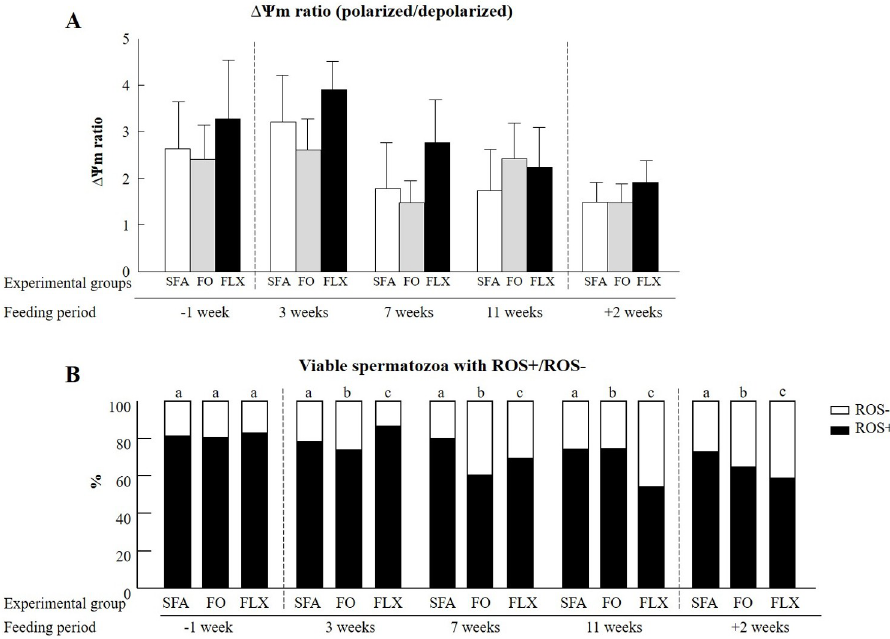
Fig 4. The effect of omega-3 sources flaxseed and fish oil on mitochondrial features. (A) The ratio of mitochondrial membrane potential ( Δ C m; polarized/depolarized) for spermatozoa from each experimental group: saturated fatty acid (SFA; control), fish oil (FO), and flaxseed oil (FLX), as determined by flow cytometer detection of the fluorescent probe JC-1 during the experimental period: before (-1 week), during (3, 7, and 11 weeks) and after (+2 weeks) the feeding trial. (B) The distribution of viable ROS+ and ROS- spermatozoa within each experimental group, as determined by flow cytometer detection of the fluorescent probe DHR123 during the experimental period. Data are presented as the mean ± SEM calculated for 5 replicates, 5000 spermatozoa for each replicate. Different letters above columns indicate significant differences between experimental groups at each time point ( P < 0.05).